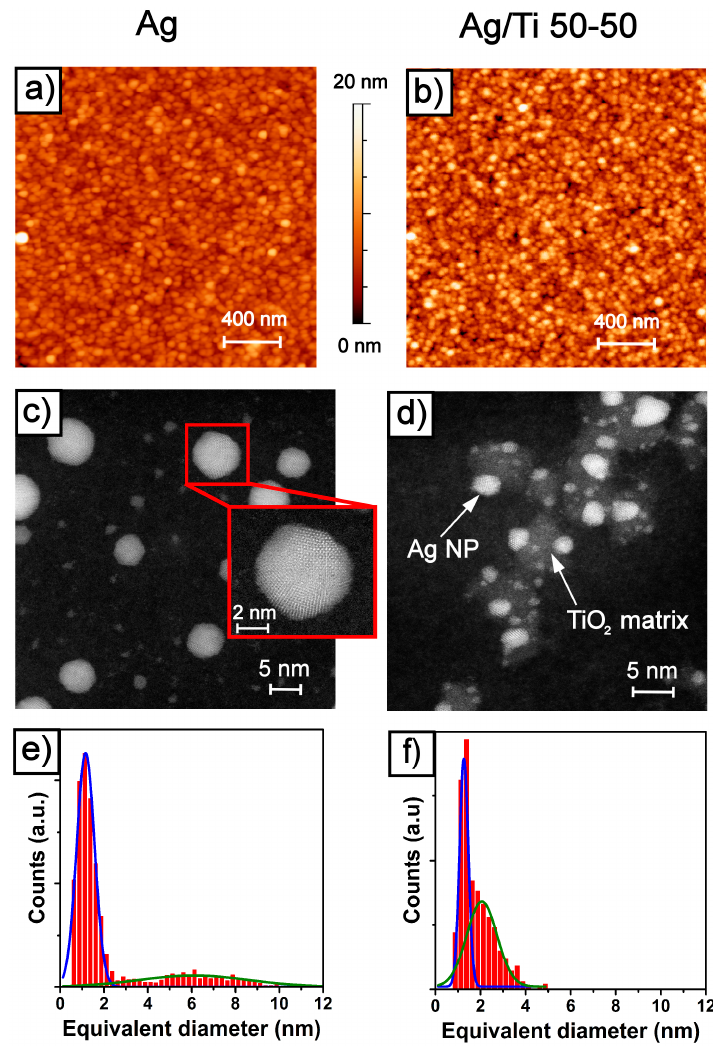
Figure 1. ( a ) AFM morphology of Ag NP film; ( b ) AFM morphology of Ag/TiO 2 nanocomposite (Ag/Ti 50-50) film; ( c ) HAADF-STEM of low coverage Ag NP film deposited on Quantifoil TEM grid with ultrathin (5 nm thick) suspended C film; ( d ) HAADF-STEM of low coverage Ag/Ti 50-50 NP film on the same type of substrate; ( e ) Ag NP size distribution as extracted from a collection of 100 frames 50 × 50 nm 2 wide ; ( f ) Ag NP size distribution as extracted from a collection of 70 frames 40 × 40 nm 2 wide, only sizes of Ag NPs embedded in oxide matrix are considered. In frames ( e , f ) Gaussian fits are superimposed on the histograms to outline the bimodal size distributions of the Ag NP sizes. The Ag/TiO 2 nanocomposite (Ag/Ti 50-50) film shows a quite different structure, as shown in Figure 1d. Due to the atomic number sensitivity of the HAADF-STEM technique (the higher Z, the higher apparent brightness), Ag (Z Ag = 47) nanocrystals are the brightest objects. The grayscale areas have been shown to be composed by a TiO 2 matrix [24] related to the lower Z numbers of the components (Z Ti = 22, Z O = 8). The Ag NPs are partially encapsulated, more similar to the Janus-like than the core-shell configuration [28], the former being commonly observed for bimetallic noble metal nanoparticles [29]. Previous investigations about the structure of the oxide matrix performed by X- ray diffraction [24] suggested that the TiO 2 is amorphous, in agreement with the TEM image shown in Figure 1d, where no sign of regular atomic arrangement can be observed in the ‘gray’ areas.